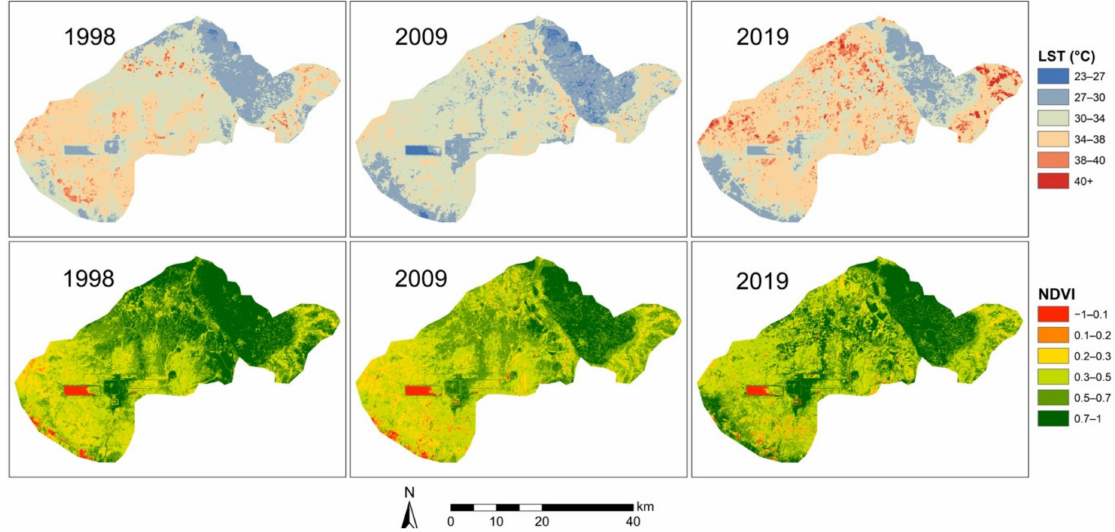
Figure 2. Results of land surface temperature (LST) and normalized difference vegetation index (NDVI) depicting spatial temperature and vegetation variation from